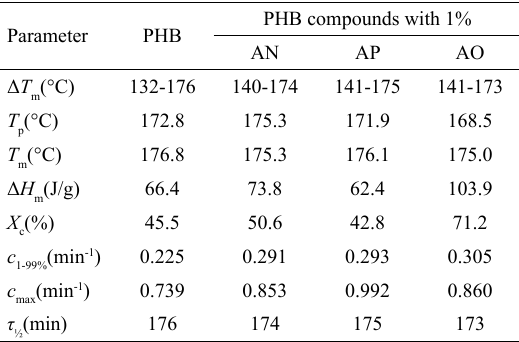
Table 4. Selected melting parameters of the second melting stage of PHB and PHB/Bentonite compounds. Parameter